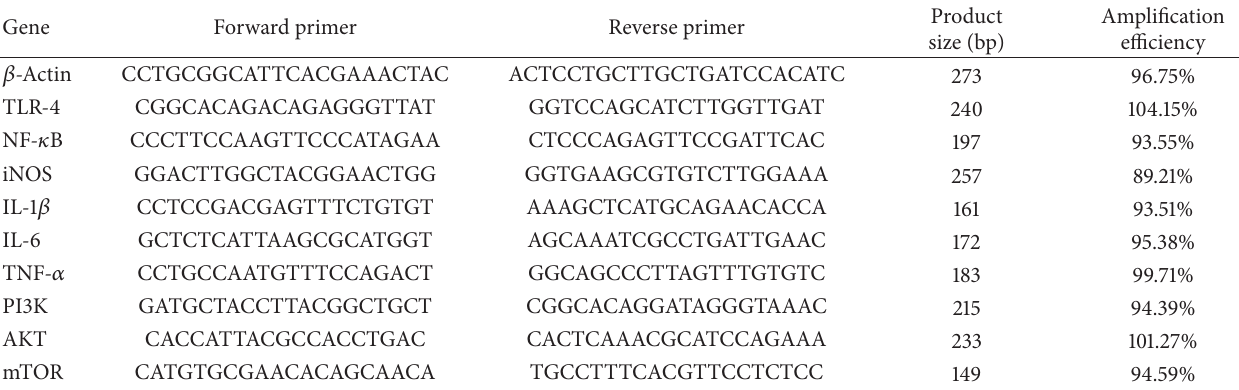
Table 1: Primers utilized for quantitative real-time PCR